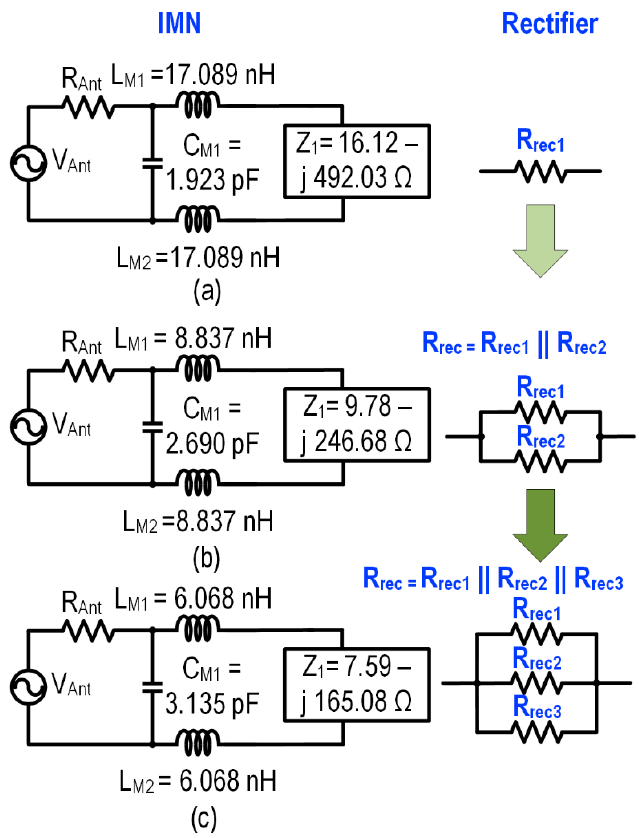
Figure 5. Impedance reduction strategy of RF front-end: ( a ) 3-stage rectifier, ( b ) 2 parallel—3-stage rectifier, and ( c ) 3 parallel—3-stage rectifier.